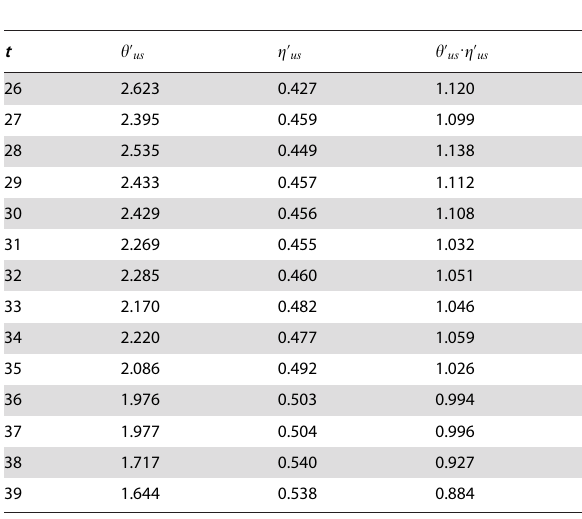
Table 2. The value of the parameters h ’ us and g ’ us for the simulation results at the early time of the period between t ~ 26 and t ~ 39